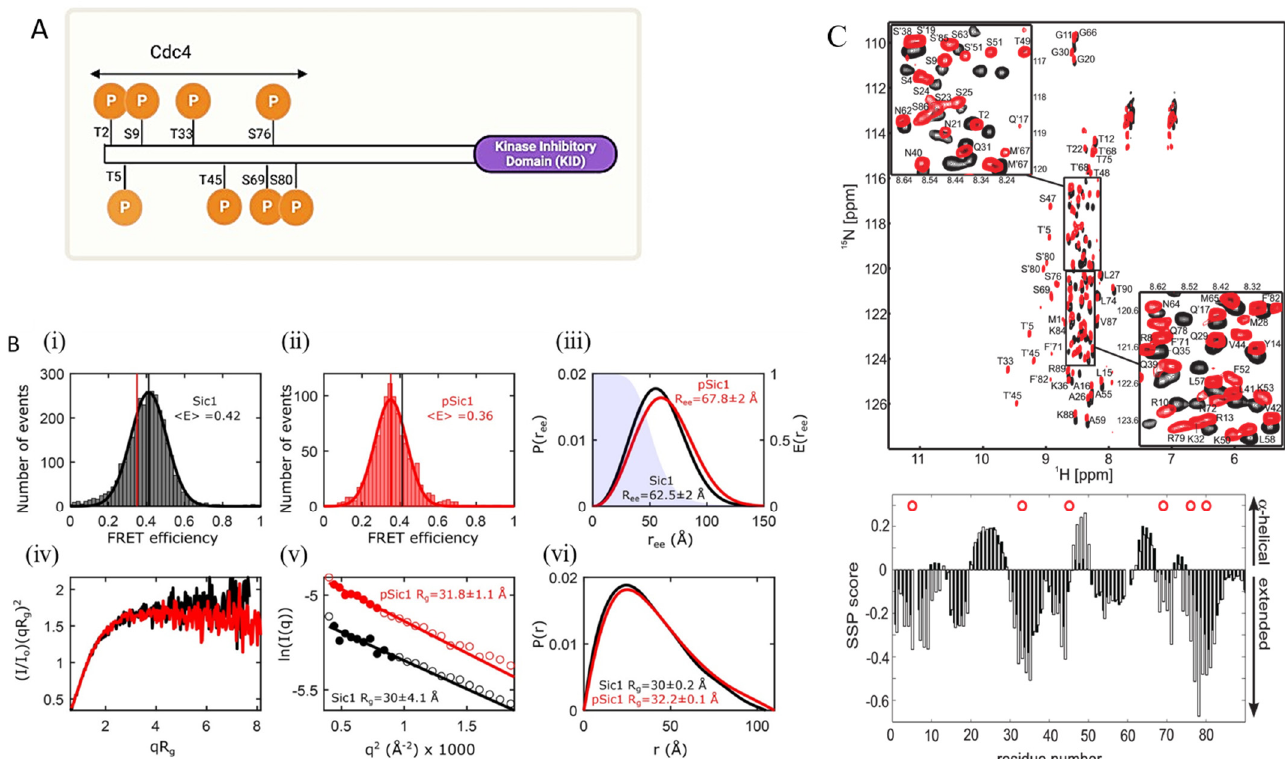
Figure 3. An integrative approach to elucidate IDP structure. ( A ) Schematic representation of full-length intrinsically disordered Sic1 protein and CPD phosphorylation sites in the N-terminal domain. The minimum functional KID fragment, the last 70 residues, is indicated in the purple box. ( B ) top three panels ( i – iii ) show smFRET efficiency histograms of Sic1 and pSic1 and end to end probability distributions. iv–vi show SAXS data for Sic1 and pSic1 and deduced R g , which was estimated to be approximately 30 Å for Sic1 and 32 Å for pSic1 [170]. (B) is adapted with permission from [170]. Copyright 2020, American Chemical Society. ( C ) Upper panel displays 1 HN- 15 N correlation spectra of Sic1 (black) and pSic1 (red). The lower panel shows experimentally determined secondary structural propensity (SSP) values (described in [175]) for Sic1 (black bars) and pSic1 (open bars). Note that the helical vs. extended interpretations are marked on the right axis. Red circles indicate the locations of the phosphorylation sites [175]. ( C ) is reproduced with permission from [175]. Copyright 2008, National Academy of Sciences,